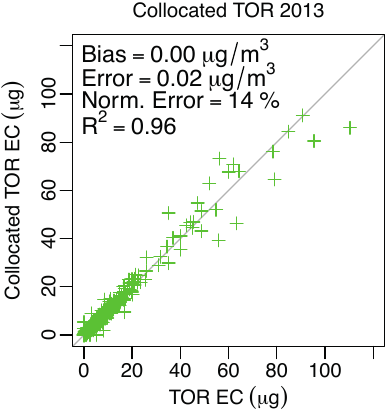
Figure 9. Scatter plot and performance metrics between the mea- surements of the collocated TOR EC. Concentration units of µgm − 3 for bias and error are based on the IMPROVE nominal vol- ume of 32.8m 3